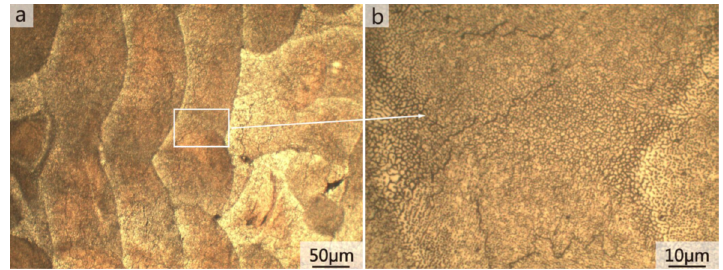
Figure 17. ( a ) Optical micrographs of SLM-processed Al-Cu-Mg samples, ( b ) a higher magnification micrograph detailing the laser tracks shown in ( a ) [117]. Copyright 2016. Adapted with the permission from SPIE publishers (Figure 4 [117]).